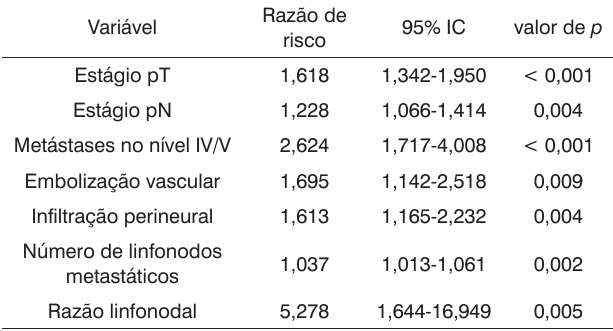
Tabela 5. Variáveis significativas identificados em análise uni - variada de sobrevivência doença-específica.